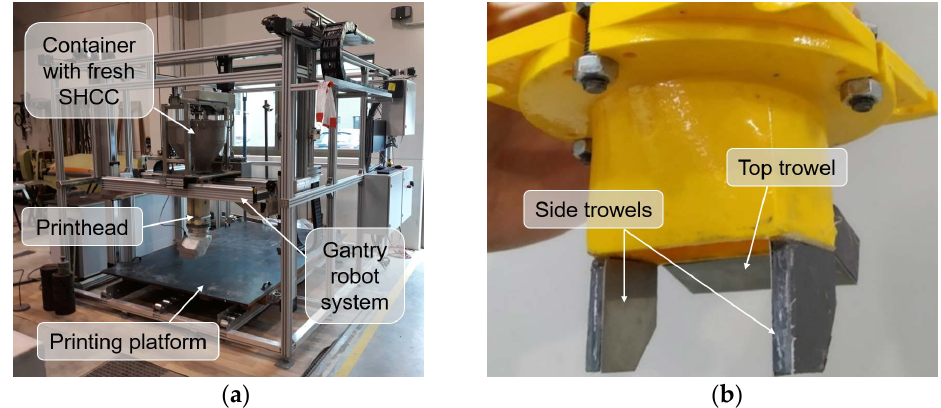
Figure 5. ( a ) Gantry 3D concrete printer and ( b ) vertically oriented nozzle equipped with side and top trowels covered with steel plates.